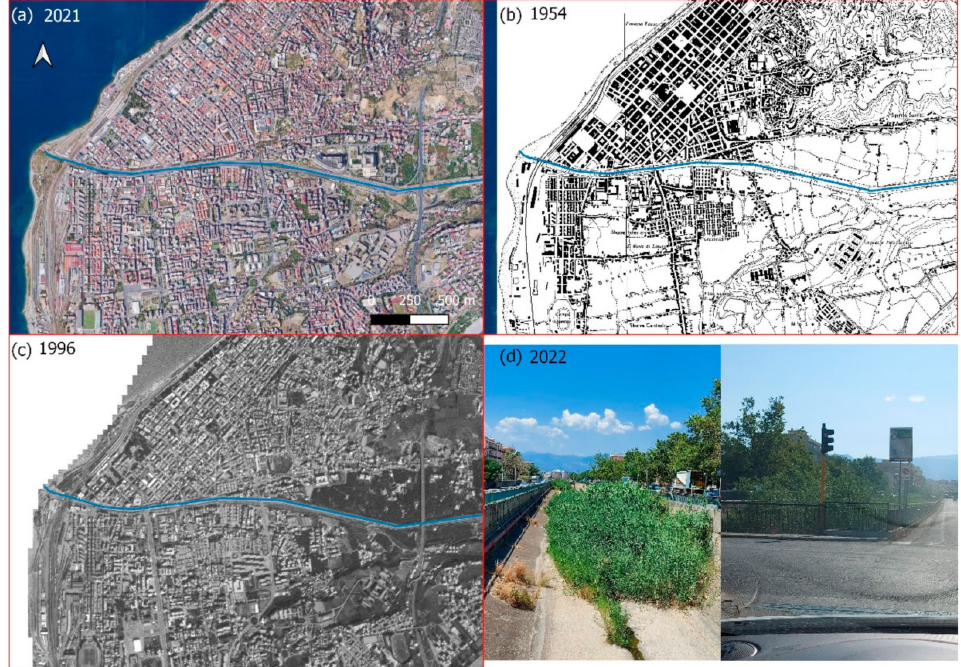
Figure 7. The Calopinace River. ( a ) An image from Google Earth from September 2021. ( b ) The CASMEZ cartography from 1954. ( c ) The orthophoto from 2006. ( d ) On the left, the view towards the mouth of the part with dense vegetation, and to the right, the view towards the mountains of the part with dense vegetation. The blue line is the Calopinace